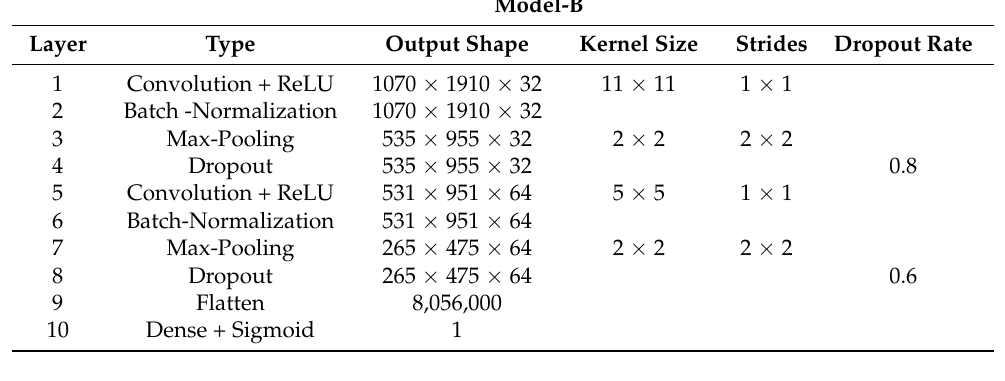
Table 2. Summary of self- developed CNN network: Model-B for DFDC image detection.